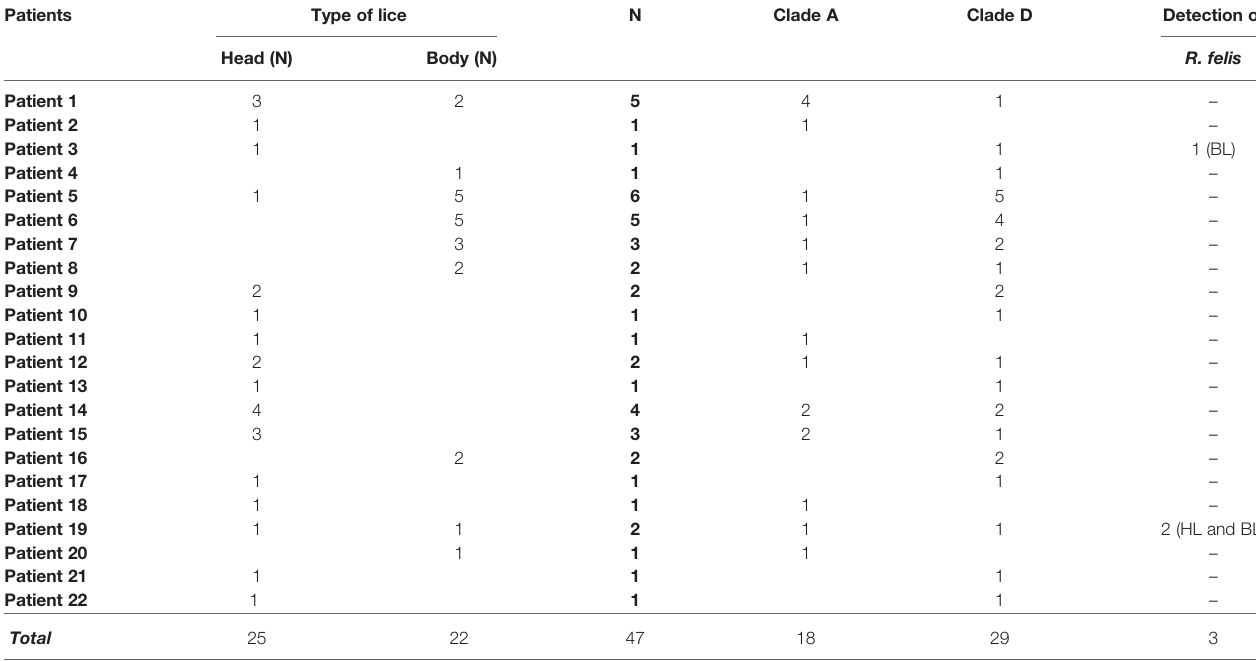
TABLE 1 | Summary of the pathogens detected in body and head lice collected from infested Mbuti pygmies in Itury,